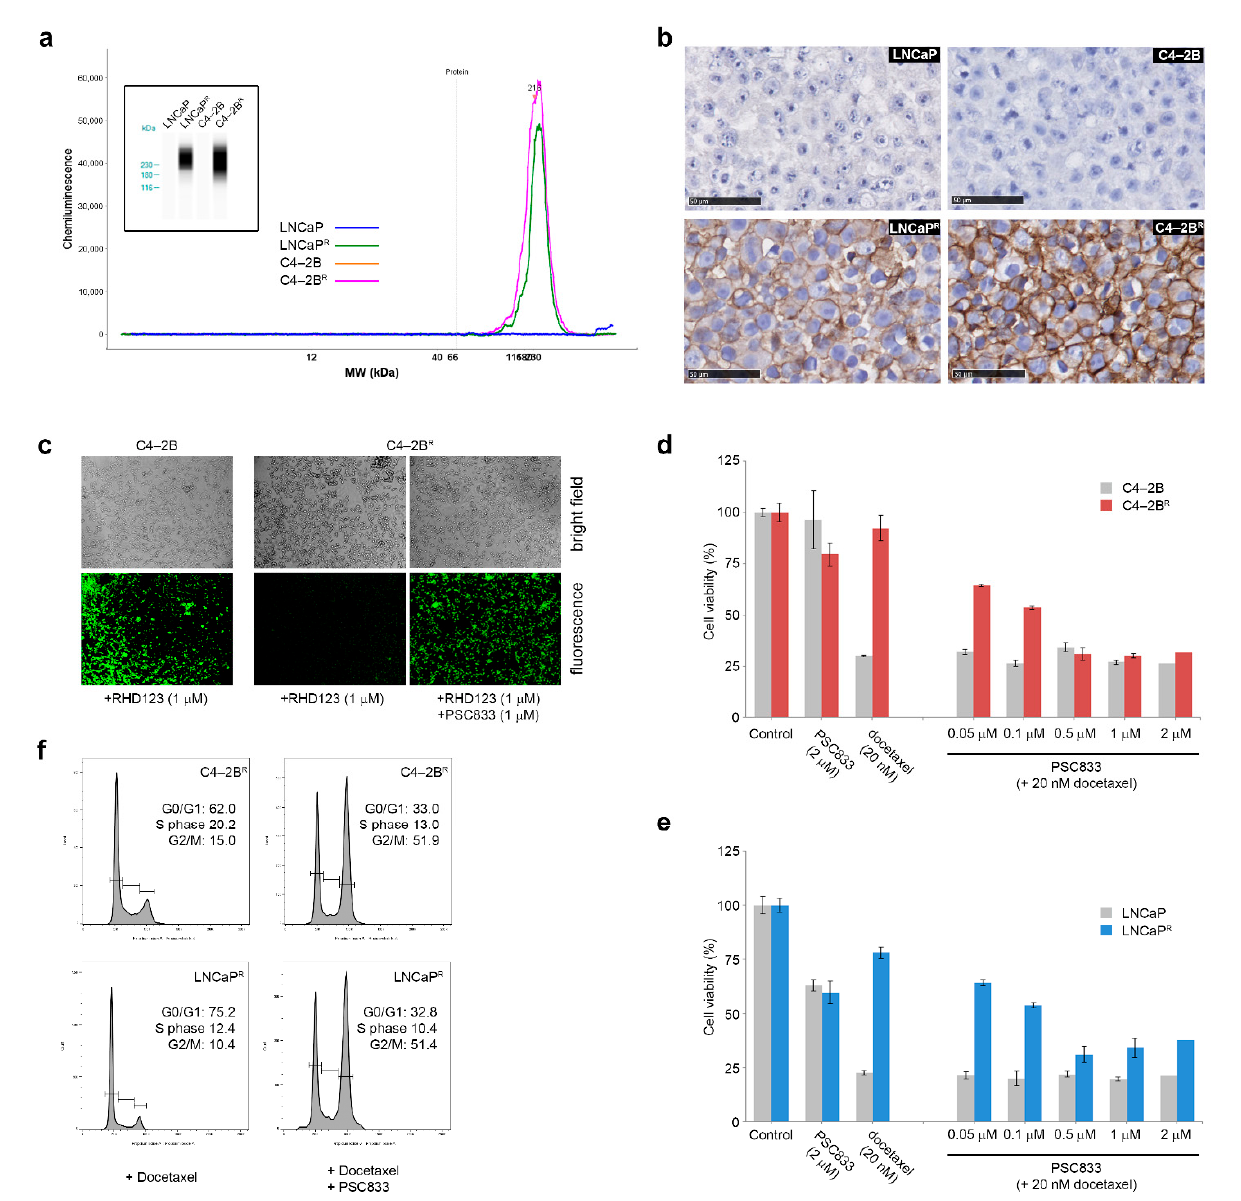
Figure 4. ABCB1 expression levels in the docetaxel-resistant cell lines. ( a ) ABCB1 expression on total protein cellular extracts was assessed by nanocapillary electrophoresis using β -actin expression as normalization factor. ( b ) ABCB1 expression was also investigated by immunocytochemistry, showing expression in docetaxel-resistant cells and a strong membrane presence. ( c ) Representative images of Rhodamine 123 accumulation in C4-2B R cells, untreated or after blockage of ABCB1 function with PSC833. Magnification, 10 × . ( d , e ) Blocking ABCB1 with PSC833 reverts resistance to docetaxel. Cells were treated for 48 h with vehicle, PSC833 alone, docetaxel alone, or a combination of 20 nM docetaxel and increasing doses of PSC833, showing that the resistance phenotype was dependent on ABCB1 function. ( f ) Flow cytometric analyses of cell cycle progression of C4-2B R and LNCaP R resistant cells treated with 20 nM of docetaxel alone or in combination with 1 µ M PSC833 for 24 h. Cells were harvested, fixed, and stained with PI for fluorescence-activated cell sorter analysis. Data were analyzed using FlowJo Software.